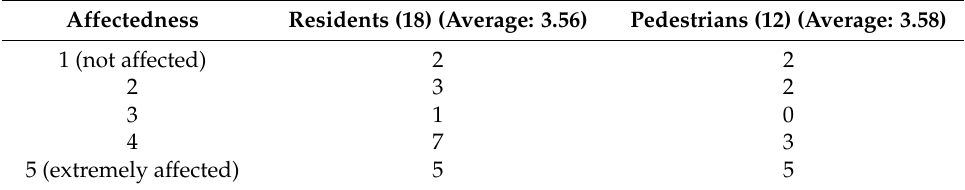
Table 2. Affectedness of direct location (Average of all answers 3.57).